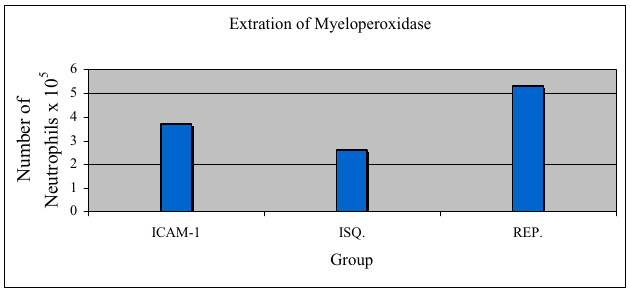
FIGURE 2 – No statistical difference between animals in the same Group was observed, however there was a significant increase in the readings from the animals of Group Reperfusion to the animals of Group Ischemia (p<0,001) and Group ICAM-1 (p<0,001). When